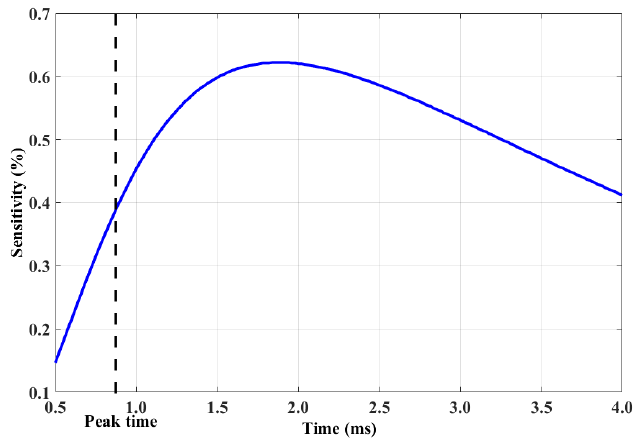
Figure 3. Sensitivity changes.